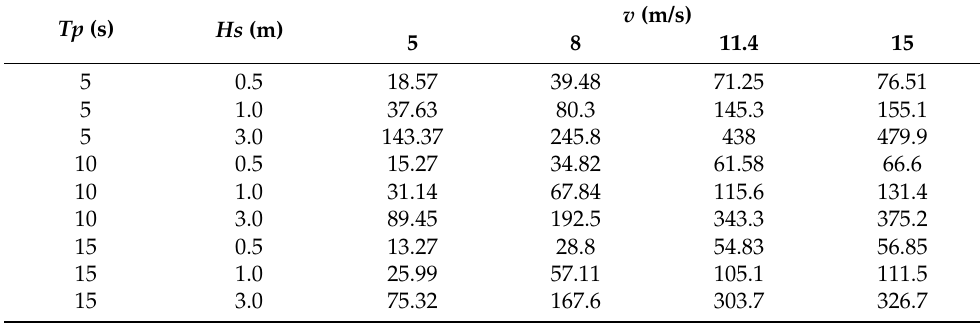
Table 11. The power fluctuation value at the given environment; units are in